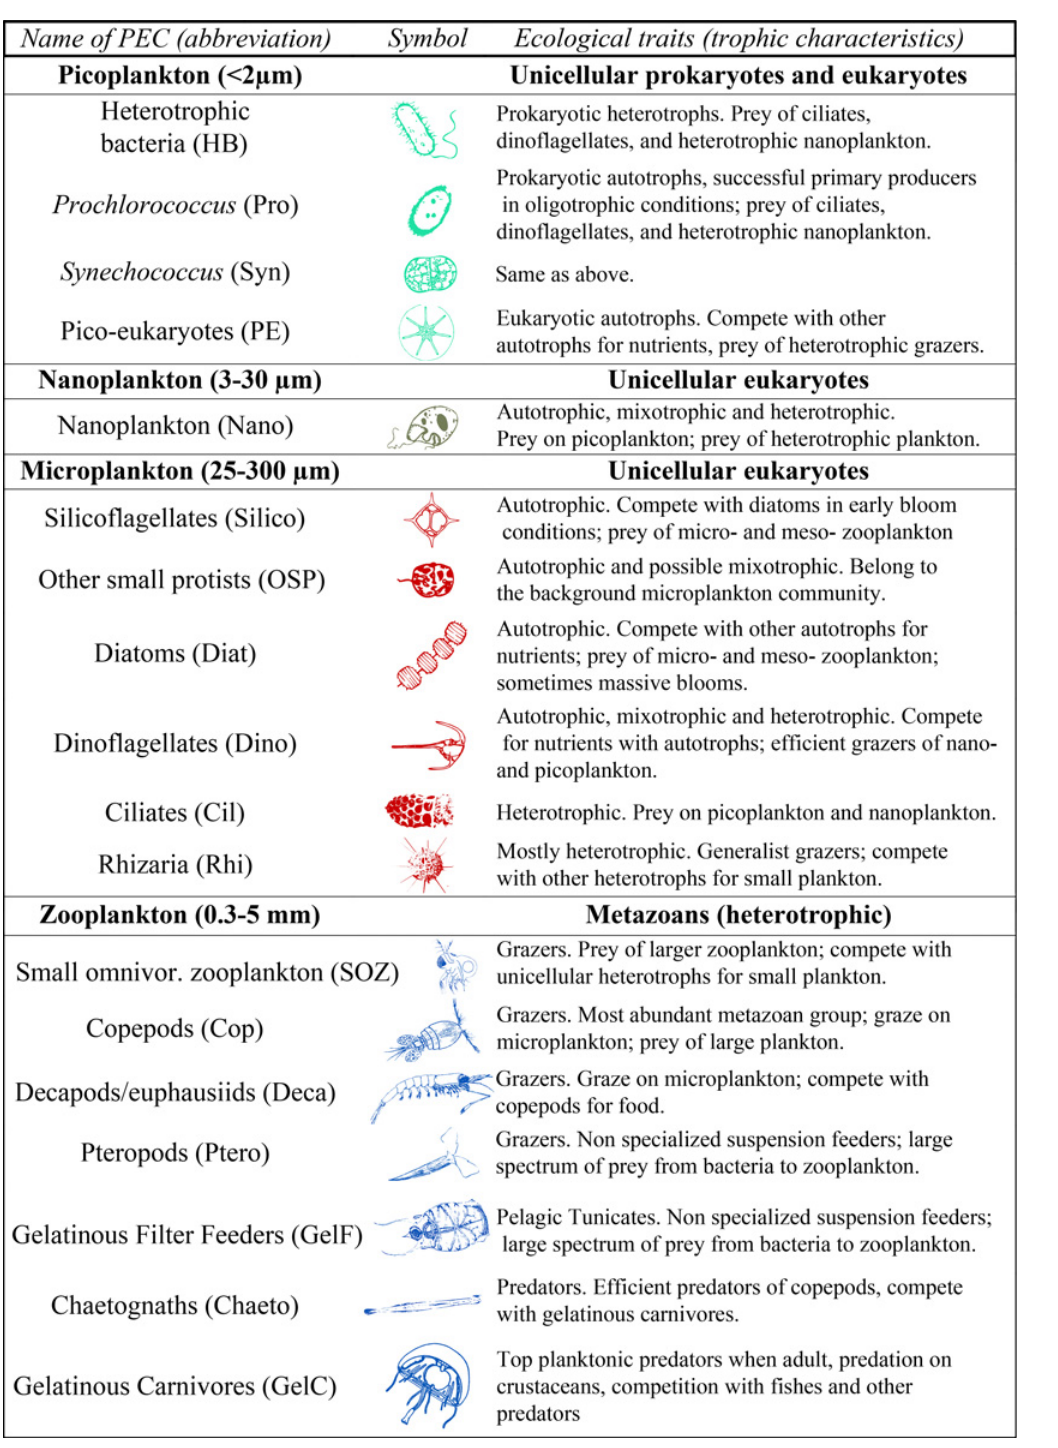
Fig 2. 18 Plankton Ecological Categories, PECs (abbreviations), symbols, and ecological traits. The symbols used as visual aid in the figures.